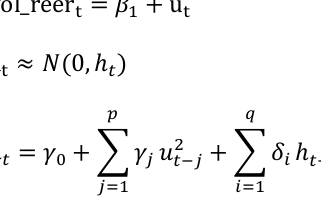
Variables used in the research model